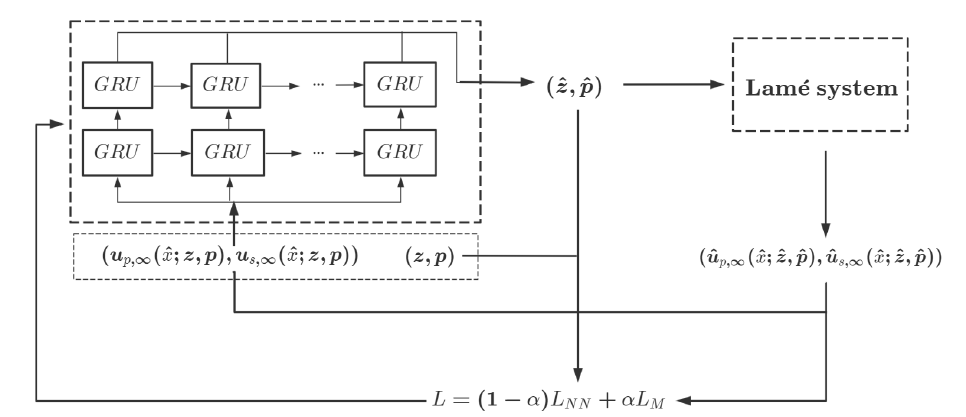
Figure 1. The structural framework of the dual-driven